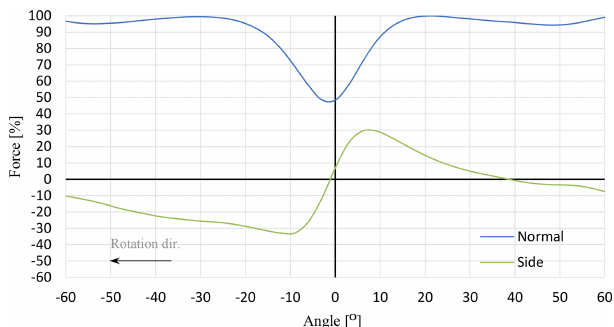
Figure 7. Aerodynamic forces on the tower for one-third rotation.